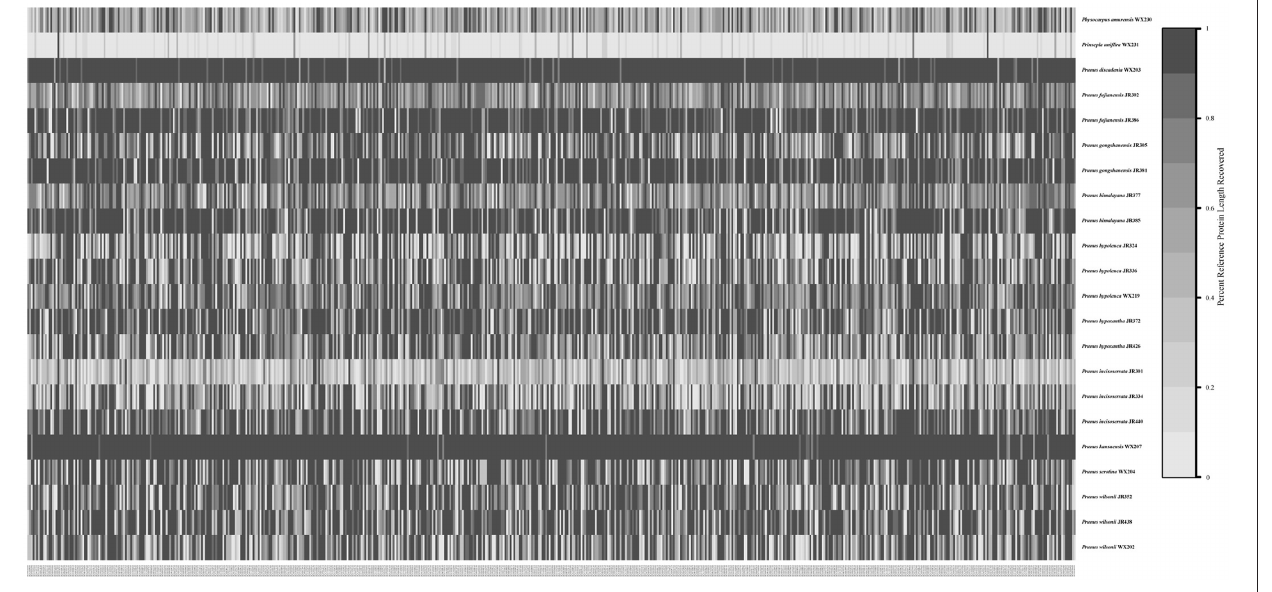
FIGURE 8 | Heat map showing recovery efficiency for 591 genes enriched in the Maddenia group recovered by HybPiper. Each column is a gene, and each row is one sample. The shade of gray in the cell is determined by the length of sequence recovered by the pipeline, divided by the length of the reference gene (maximum of